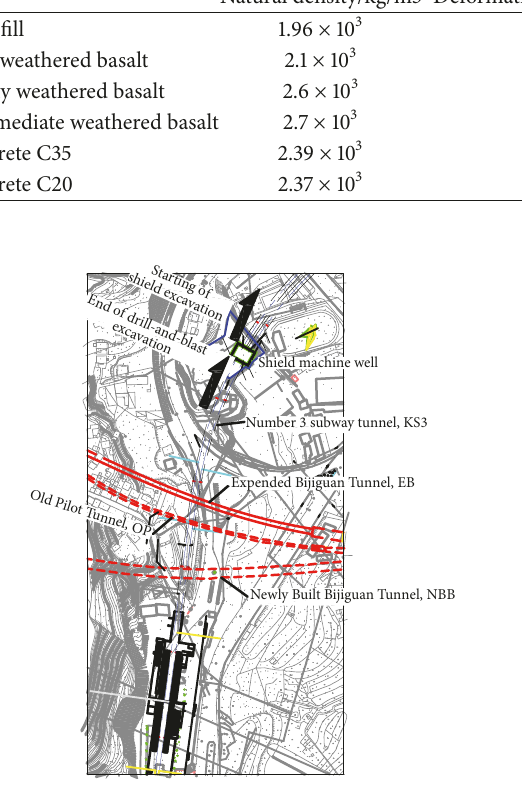
Figure 1: Plan of KS3 tunneling overlying three existing tunnels.